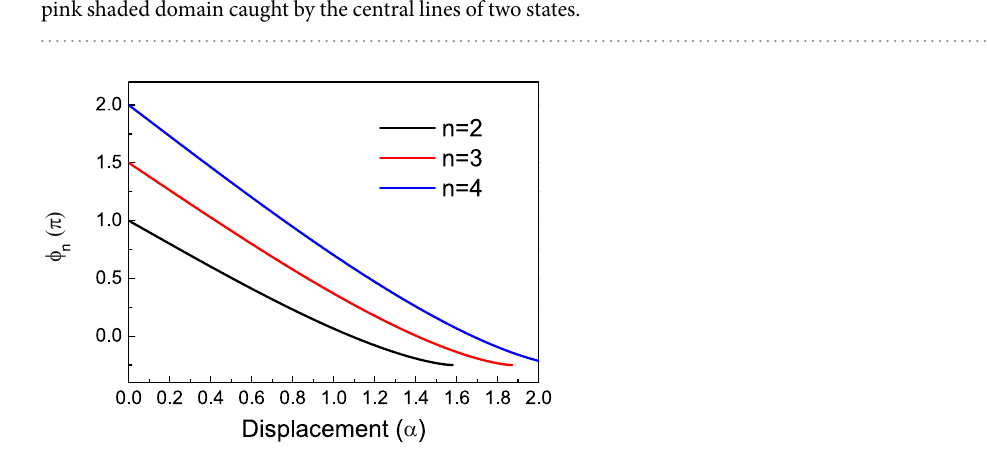
Figure 3. Phase associated with overlap in phase space ( φ n ) as a function of displacement ( α ) for n = 2, 3, and